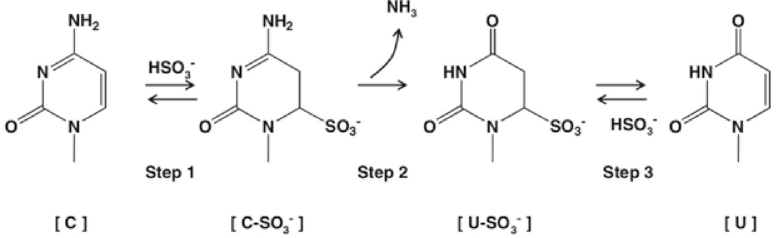
Fig 2. A diagram showing the 3base conversion process at the nucleotide level. The bisulphite reaction deaminates cytosine residues in nucleic acids to a uracil sulphonate. After treatment the base is then desulphonated to yield uracil. PCR amplification then converts this to a thymine, which results in essentially a 3base genome (A, G and